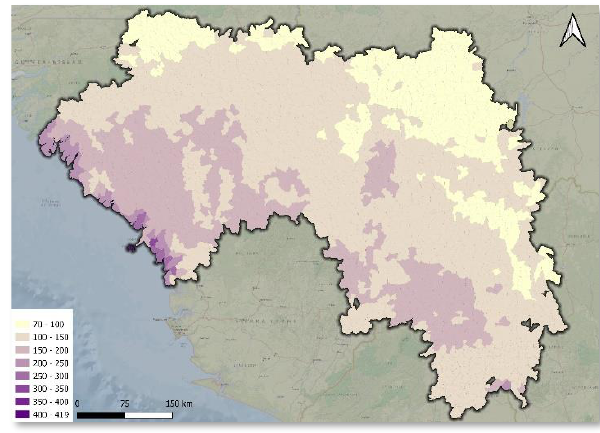
Figure 11. Average rainfall (mm) for 2005 (top) and 2015 (bottom)